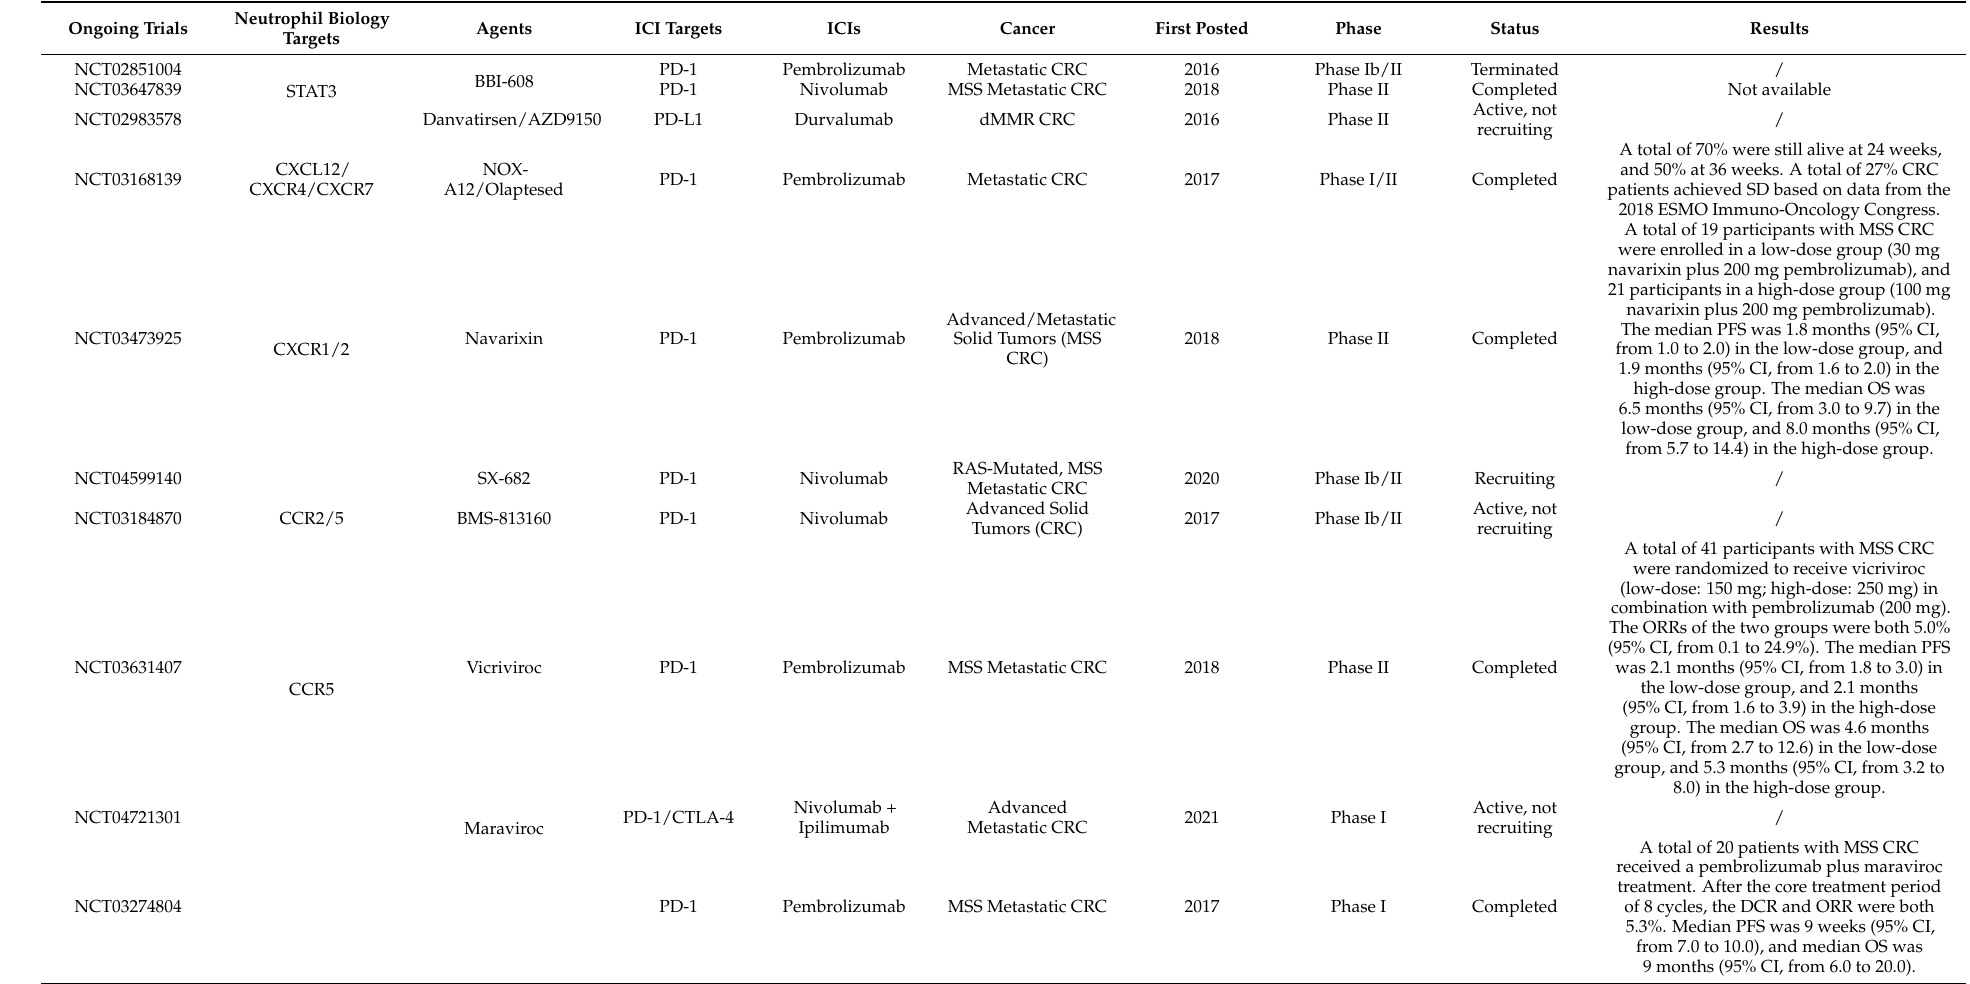
Table 2. Ongoing clinical trials combining ICI blockades and agents related to neutrophil